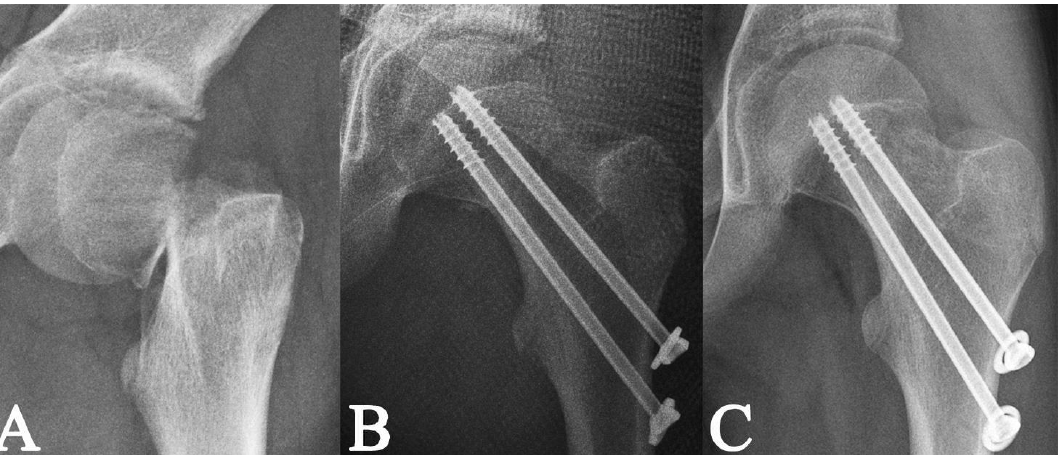
Figure 8. Radiographs of a 12-year-old boy with a displaced Delbet – Colonna type II fracture [15] ( A ); radiographs after open reduction and internal fixation with 2 cannulated ˄ -shape screws; the fracture was completely compressed by the screws with the threads above the fracture line ( B ); the radiological healing at 2.8 months post-surgery ( C ).